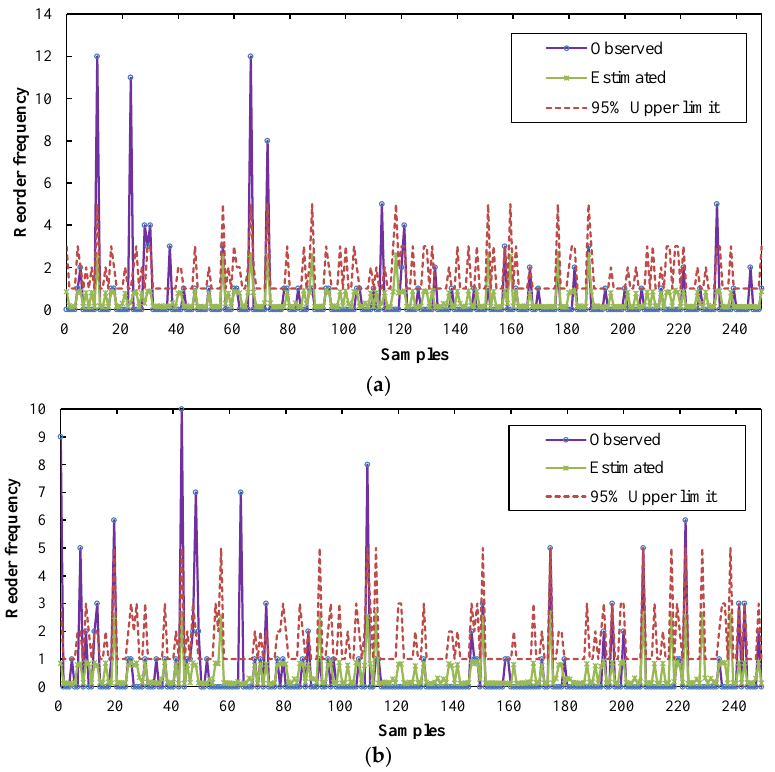
Figure 8. Observed and estimated reorder frequency with 95% upper limits by Monte Carlo simulations. ( a ) Training observed and estimated reorder frequency with 95% upper limits. ( b ) Test observed and estimated reorder frequency with 95% upper